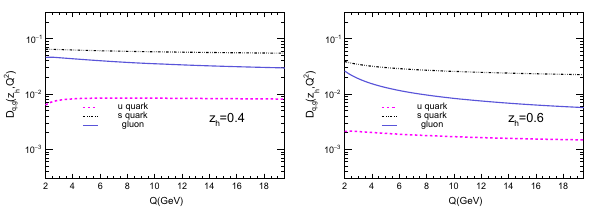
Fig. 2 Left φ FFs as a function of the scale Q at z h = 0 . 6; right φ FFs as a function of the scale Q at z h = 0 .